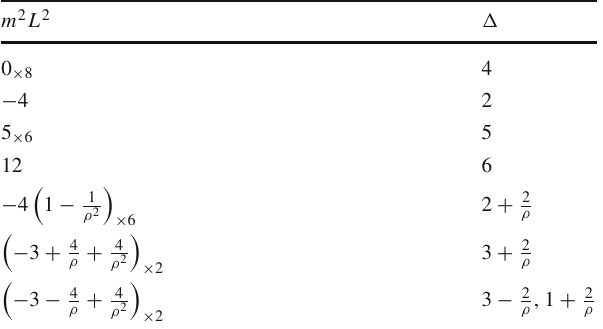
Table 2 Scalar masses at the N = 4 supersymmetric AdS 5 critical point II with SO ( 2 ) D × SO ( 3 ) diag symmetry and the corresponding dimensions of the dual